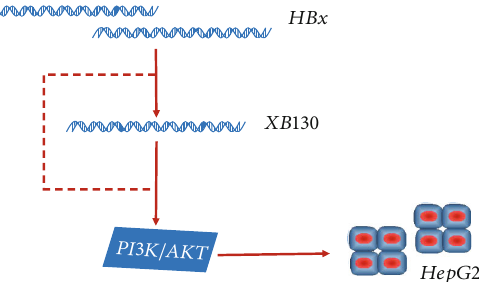
Figure 8: Schematized analysis showing that HBx promotes activity of PI3K/AKT pathway by binding to XB130, which enhanced proliferation, migration, and invasion of HepG2 cells and curtailed cellular